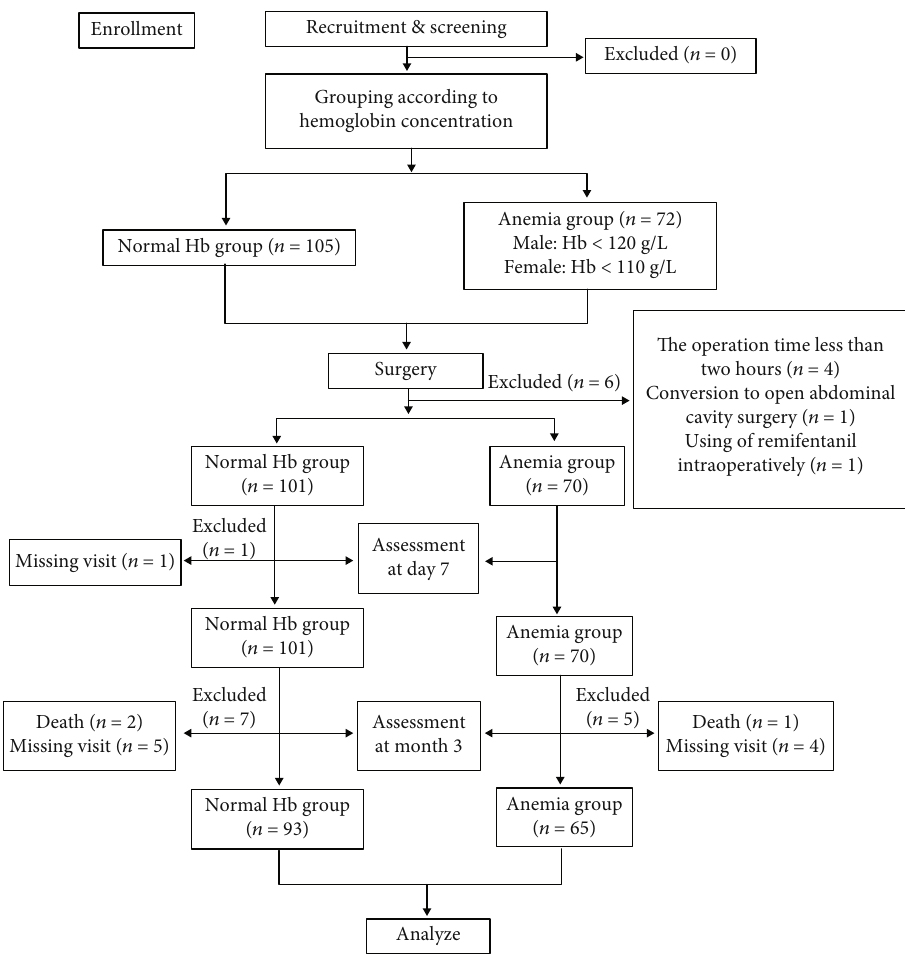
Figure 1: Patients included and excluded in our